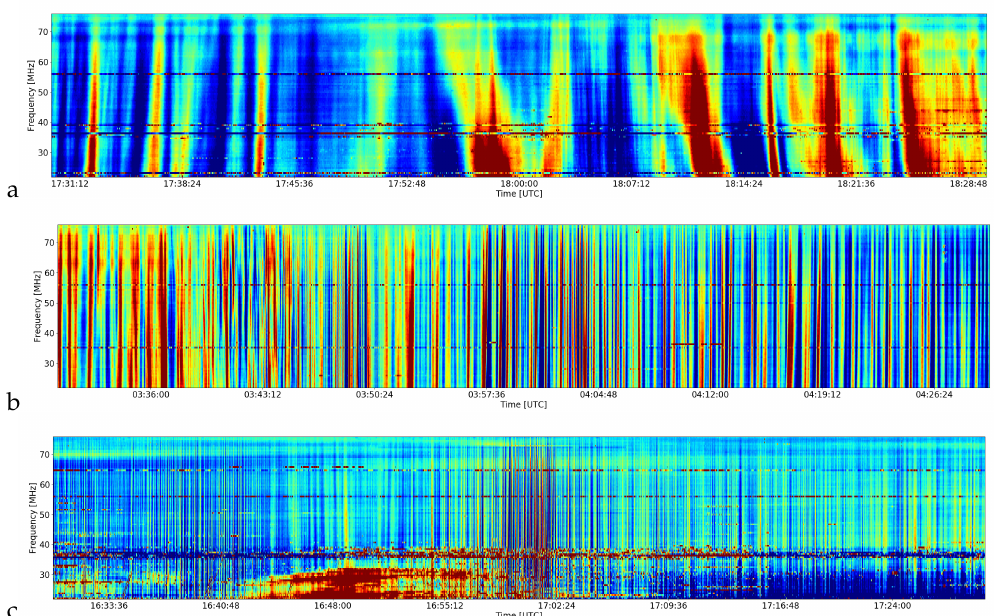
Figure 6. Amplitude dynamic spectra: ( a )—L547449 set; ( b )—L547785 set; ( c )—L552177 set.